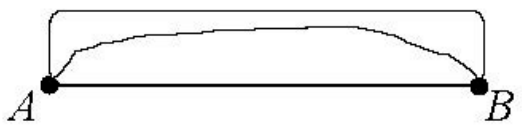
Figure 2. Distance between two points (The line segment between two points is the shortest).